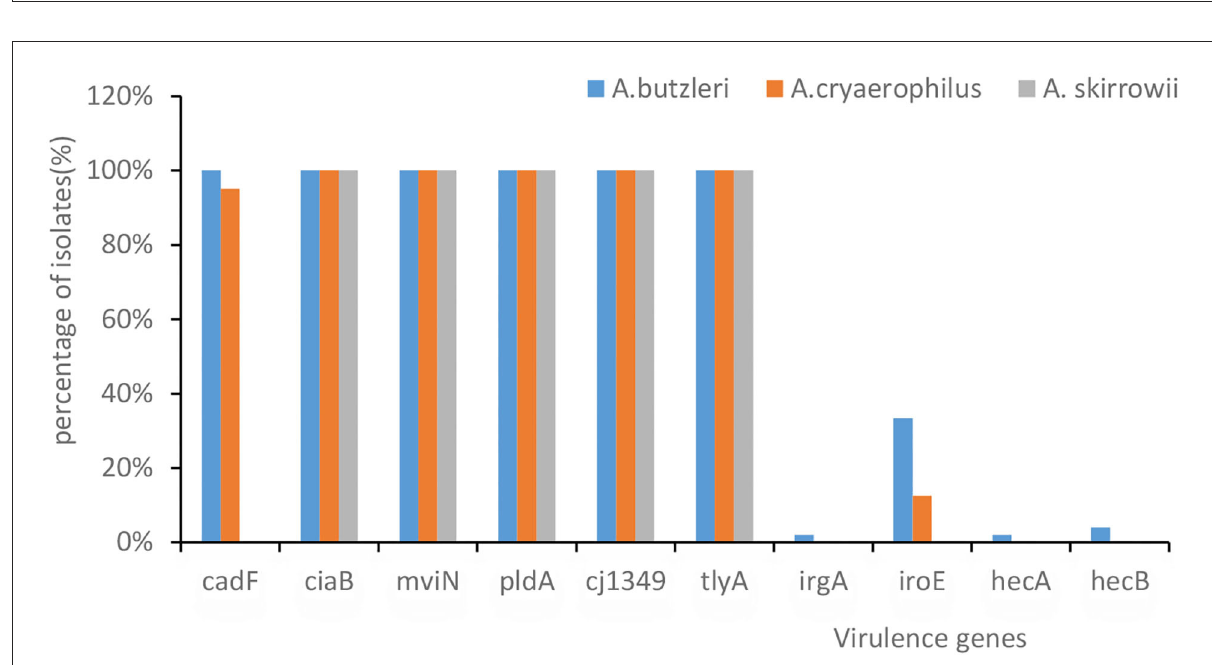
FIGURE2 The presence of virulence-associated genes in Arcobacter spp. The x -axis represents the virulence genes. The y -axis represents their percentage of isolates. The color of the columns corresponds to the organisms.